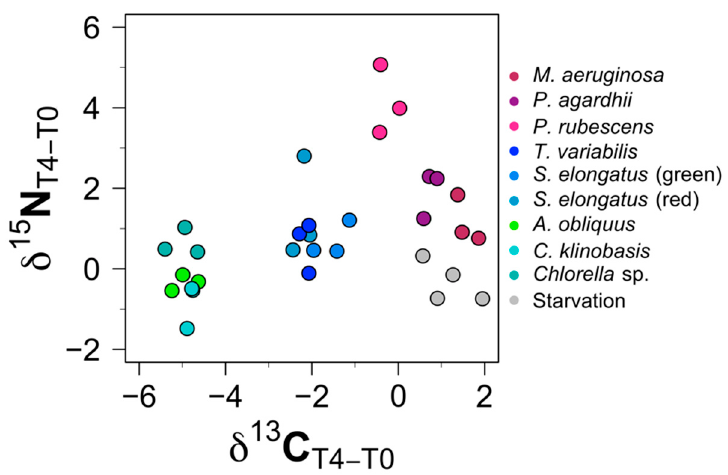
Figure 4. Changes in isotopic signatures of D. magna tissues over time (96–0 h after diet change) in the different dietary treatments.